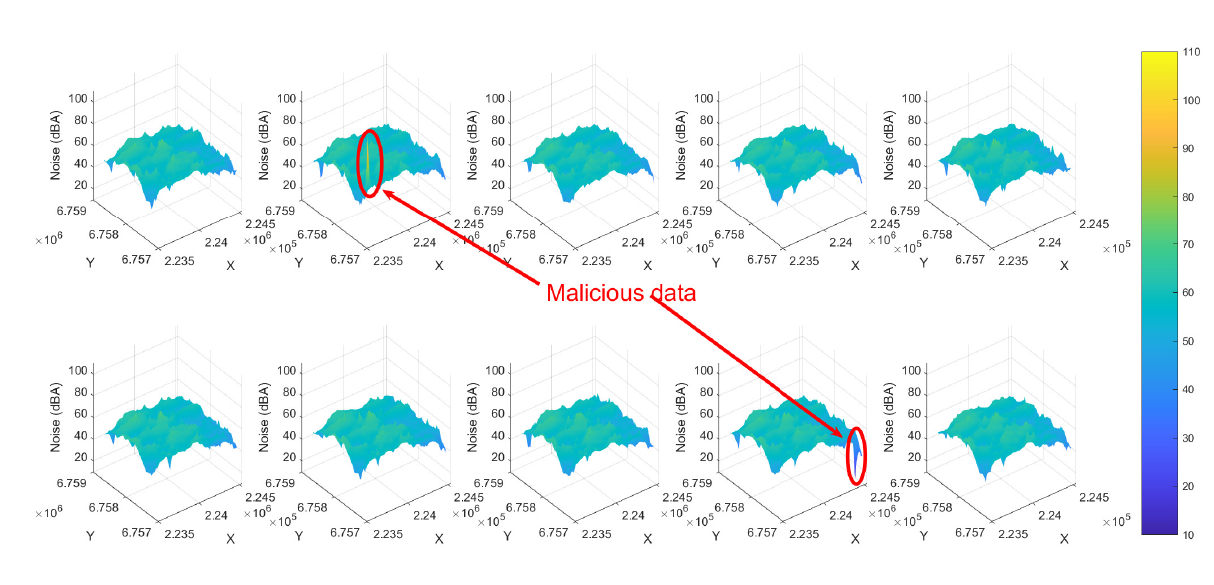
Next, we demonstrate (empirically) the approach pre- sented in Section 5.1 to maintain data reliability for the all non-malicious users (view (a)) and two partial dataset of N = 5000 participants. However, instead of gen- erating one noise map by considering measurements of all the participants (as shown in Figures 1, 2), the application server will randomly partition the participants into (say) 10 groups of 500 participants each, and generate ten separate (partial) noise maps (one corresponding to each group). Moreover, these groups are shuffled after each iteration.